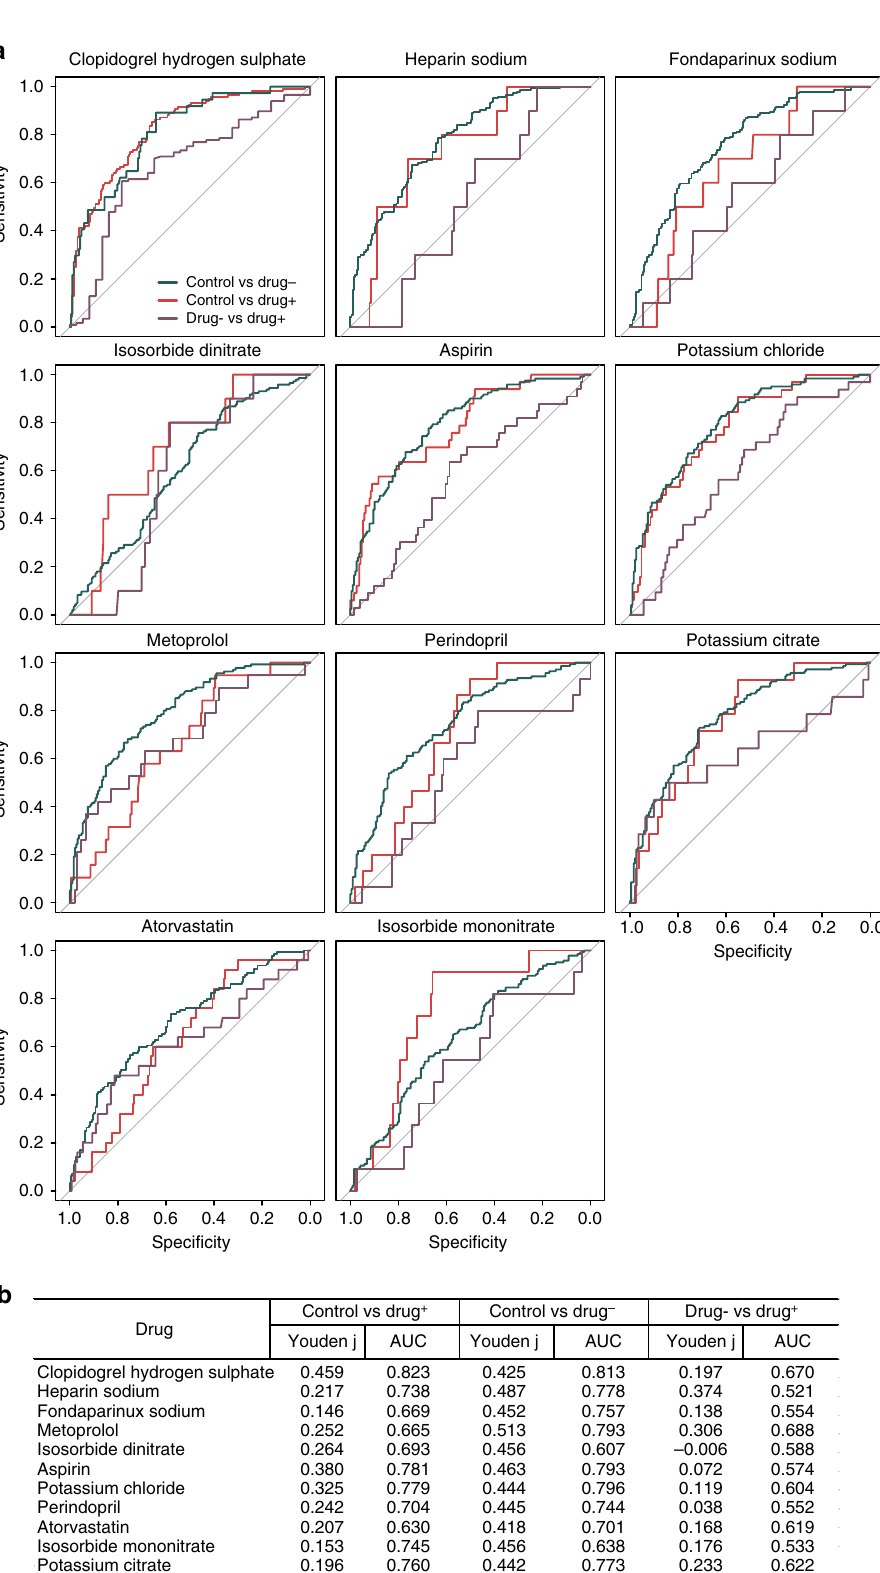
Fig. 5 Performance of random forest classi fi ers for ACVD samples strati fi ed by medication. a ROC for two-way classi fi cation models of ACVD patients with and without the drug and healthy controls. Fivefold cross-validation repeated fi ve times. Numbers of individuals treated with each drug are given in Supplementary Data 2. b AUC and Youden ’ s index for the ROC plots in